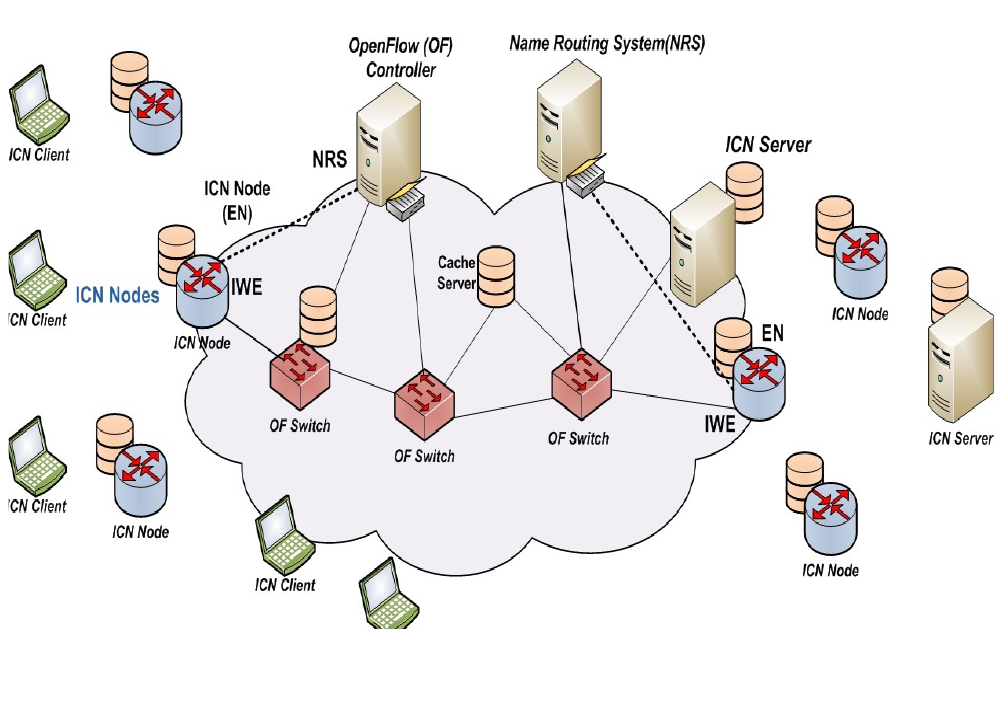
Figure 2. Details of OpenFlow solution to support ICN [14].